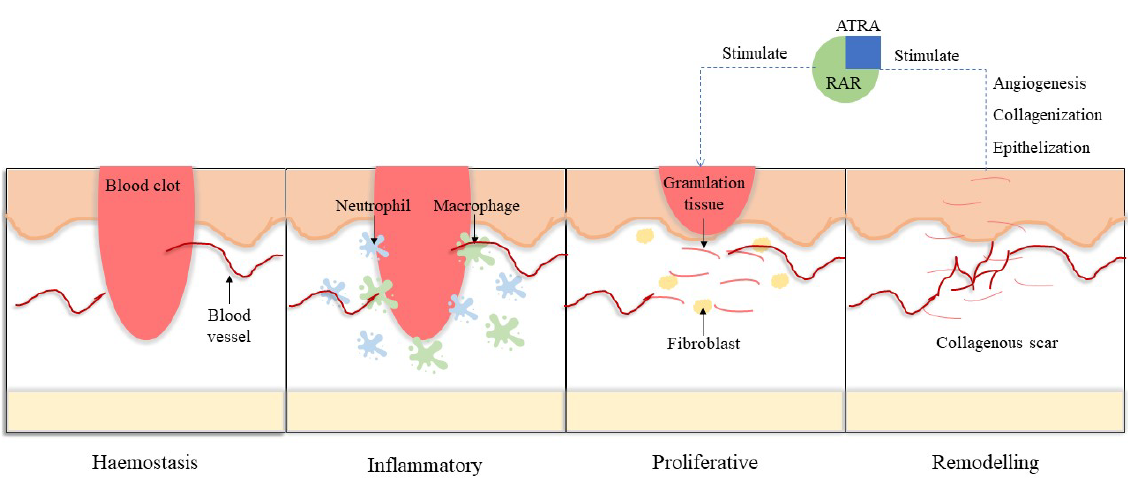
Figure 6. Action of ATRA in the stages of wound healing.